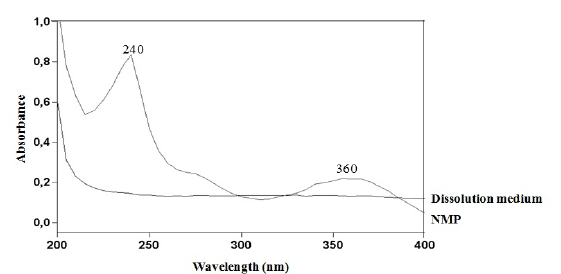
Figure 4. Scan spectra of the dissolution medium and NMP hydro alcoholic solution, from 200 to 400 Table 2. Intra- and inter-day precision data respective to the intrinsic dissolution method. Intra-day